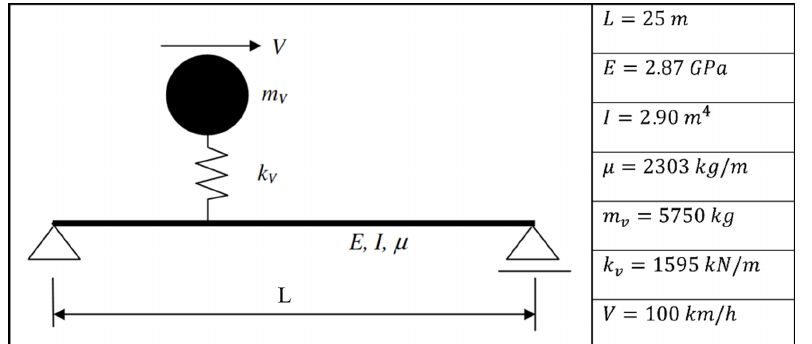
Figure 1. Verification